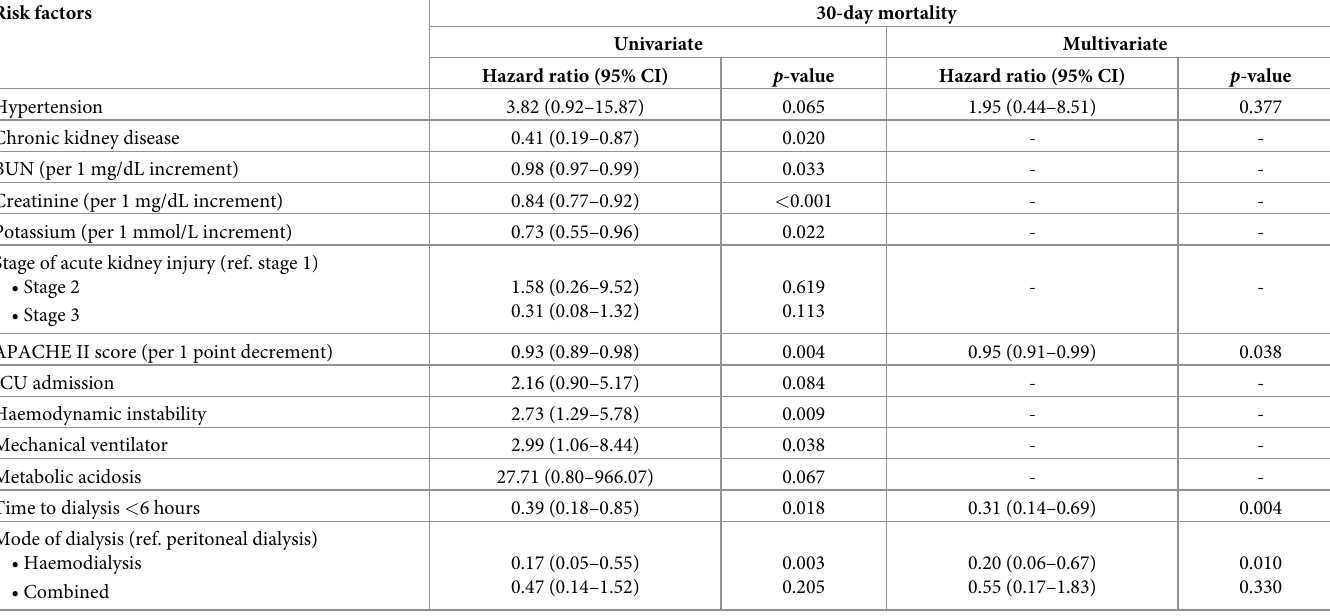
To examine the association between risk factors and disease mortality, high APACHE II score, ICU admission, haemodynamic instability, mechanical ventilator requirement, and time to dialysis 6 hours or longer (late dialysis) and peritoneal dialysis were significantly asso- ciated with higher risk of 30-day mortality, using univariate Cox regression model. Chronic kidney disease, high serum BUN, creatinine and potassium levels seemed to be protective fac- tors of disease mortality. Additionally, compared to PD, HD was significantly associated with lower risk of 30-day mortality, using univariate Cox regression model ( Table 2 ). Table 2. Association between risk factors and 30-day mortality in patients with metformin-associated lactic acidosis, using univariate Cox-regression